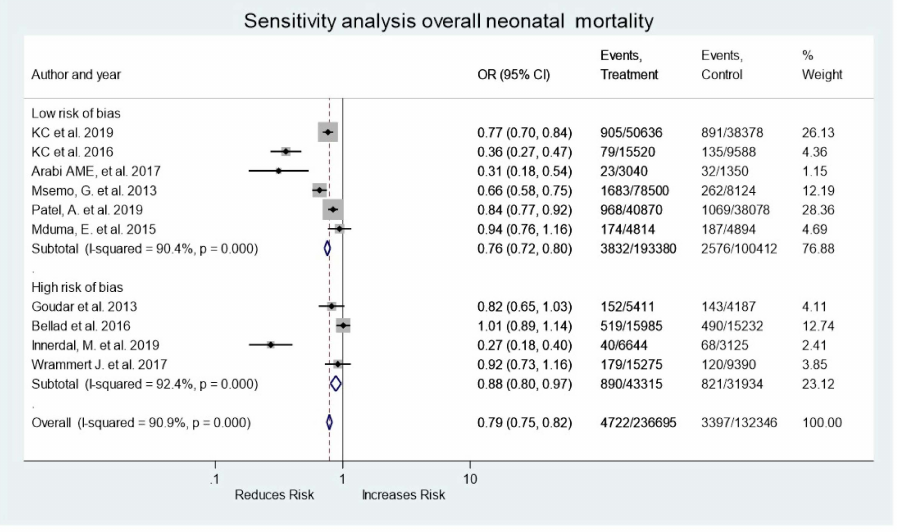
Figure 4. Forest plot for sensitivity analysis for overall neonatal